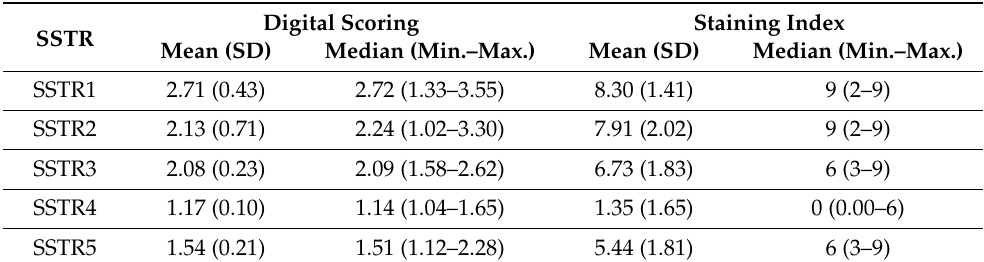
Table 3. Digital scoring and staining index of immunohistochemical expression of SSTRs in human meningiomas. The digital score goes from 1 to 4, whereas the staining index goes from 0 to 9. Digital Scoring Staining Index SSTR Mean (SD) Median (Min.–Max.)